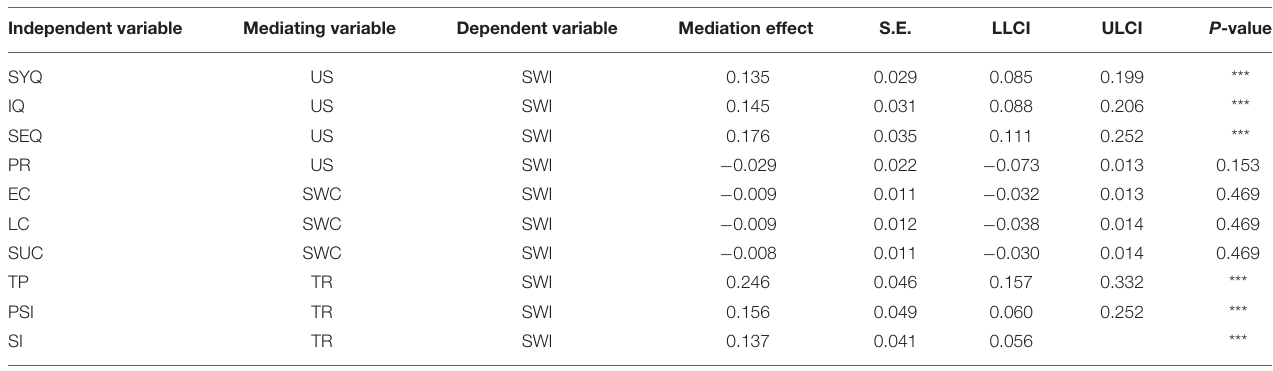
TABLE 6 | Mediating effect